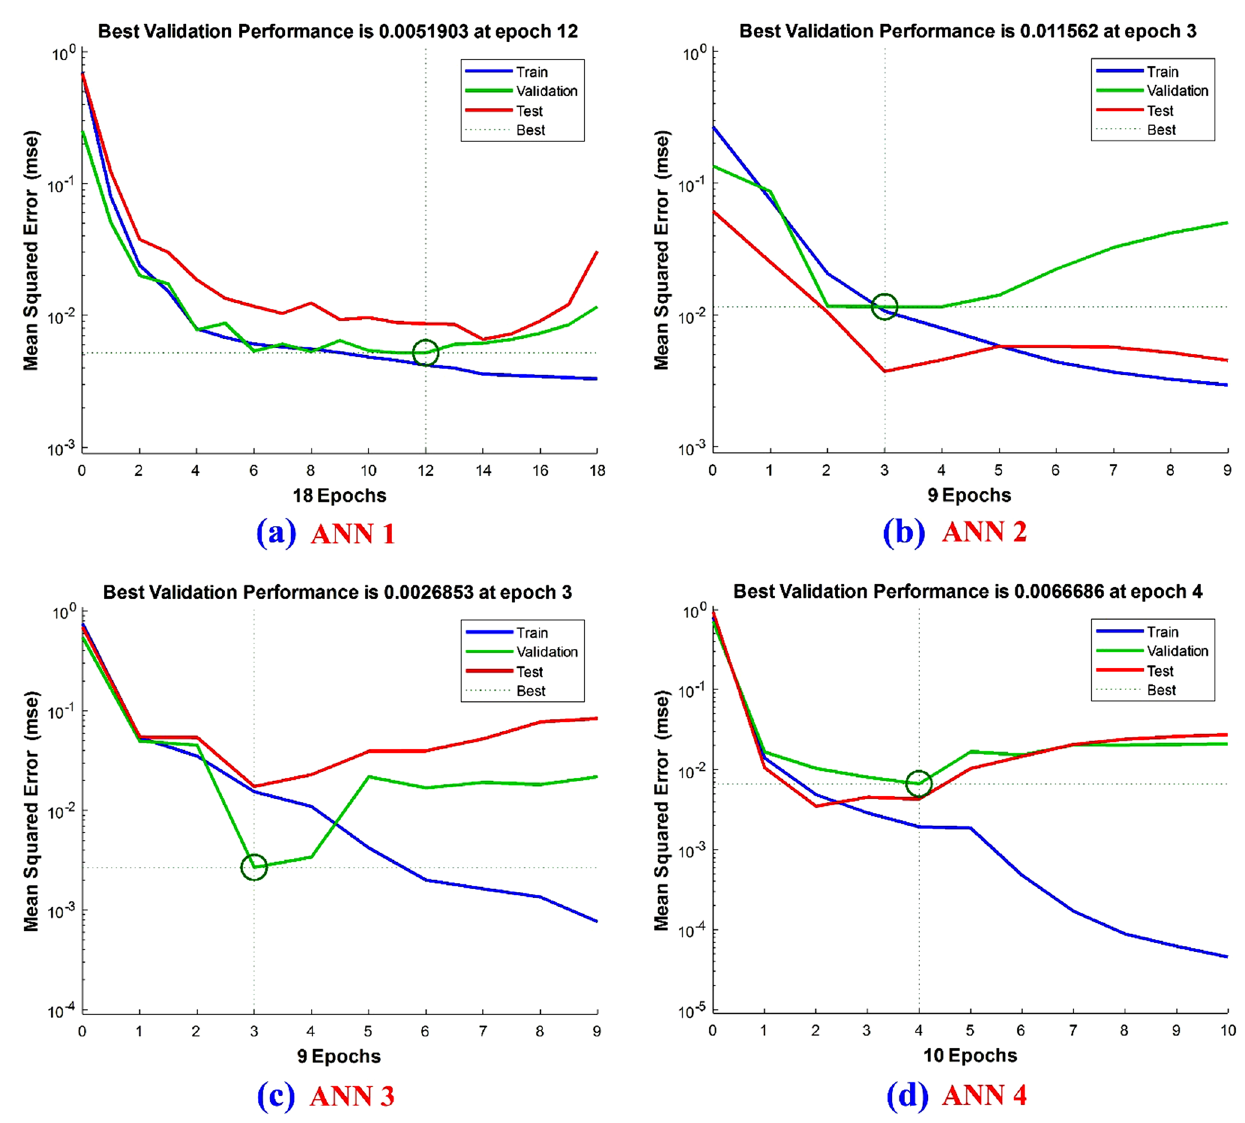
Fig. 19 The performance of the ANN models for liquefaction prediction, a Model No.1 (ANN 1), b Model No.2 (ANN 2), c Model No.3 (ANN 3), d Model No.4 (ANN